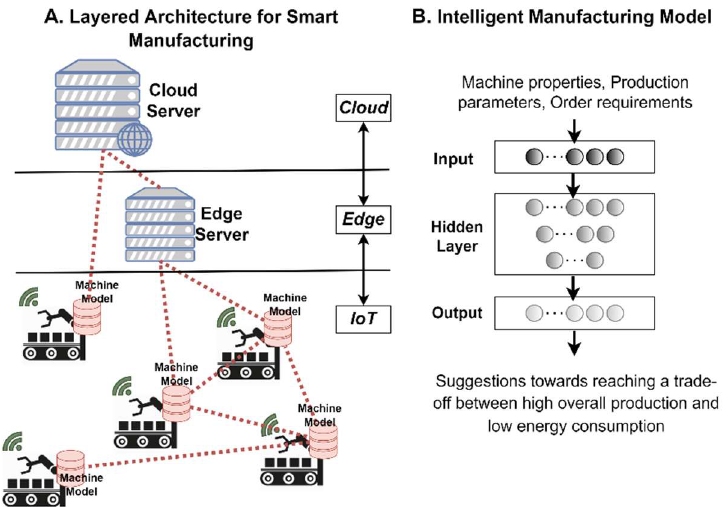
Figure 8. Implementation of the RAMOS layered architecture in data and ML model sharing amongst several factory sites towards carbon-neutral manufacturing.